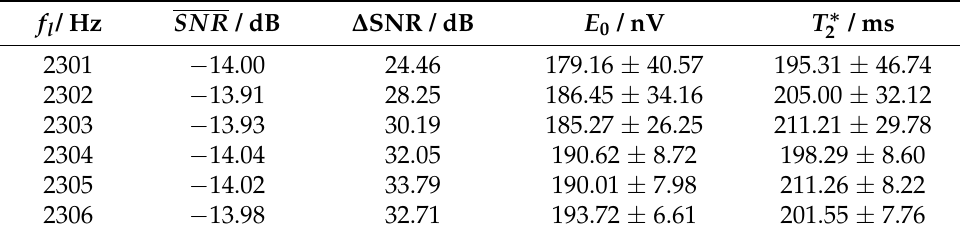
Table 2. Denoising results under different Larmor frequencies f l